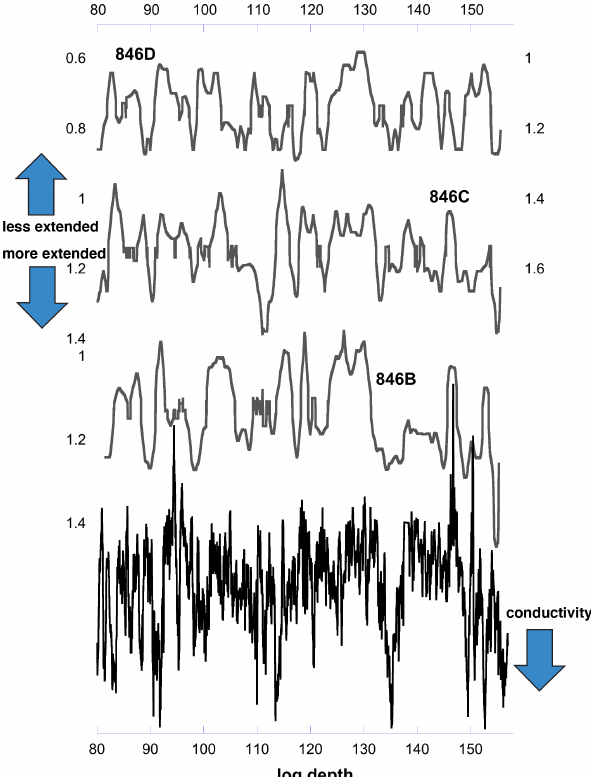
Figure 3. Composite sections of GRAPE density generated using the Match algorithm for holes 846B, C, and D, on a new composite depth section, compared to the inverse conductivity log depth. All data sets were detrended and normalized for this comparison. Cor- ing gaps at each hole have been filled in from offset holes to make continuous